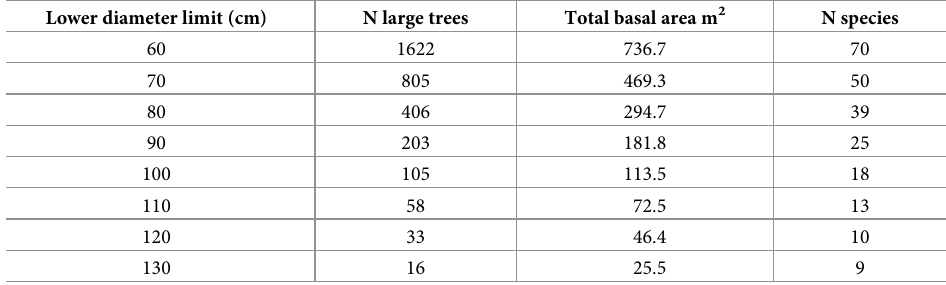
Table 3. Large tree species diversity by